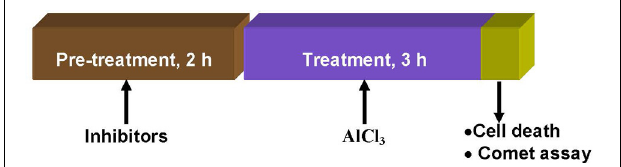
FIGURE 1 | Treatment protocol showing time and sequence of pre-treatment, treatments, and endpoints measured in root cells of A. cepa